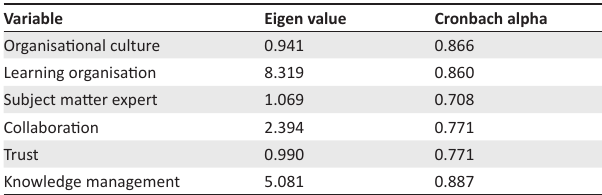
Callaborative knowledge tree model for government sector problem solving